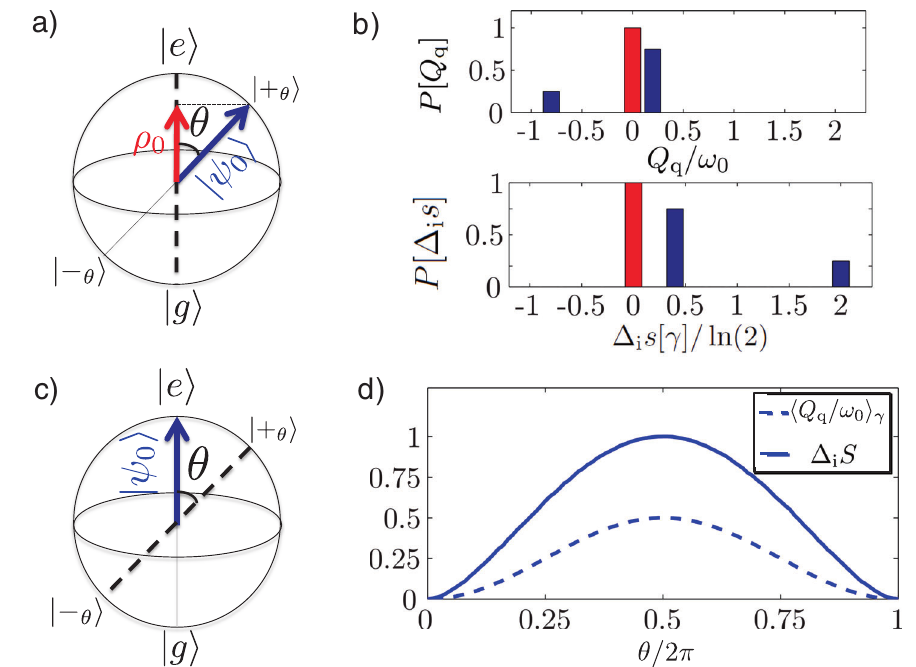
Fig. 2 Distributions of quantum heat P [ Q q ] for simple protocols de fi ned by the preparation and measurement of a Qubit in arbitrary bases { | + θ 〉 ; | − θ 〉 }, with þ θ j i ¼ cos ð θ = 2 Þ e j i þ sin ð θ = 2 Þ g j i and (cid:2) θ j i ¼ (cid:2) sin ð θ = 2 Þ e j i þ cos ð θ = 2 Þ g j i . | e 〉 and | g 〉 are the excited and ground states of the Qubit of respective internal energies U e ¼ ħ ω 0 = 2 , and U g ¼ (cid:2) ħ ω 0 = 2 . a , b Energetic and entropic signatures of quantum measurement. a